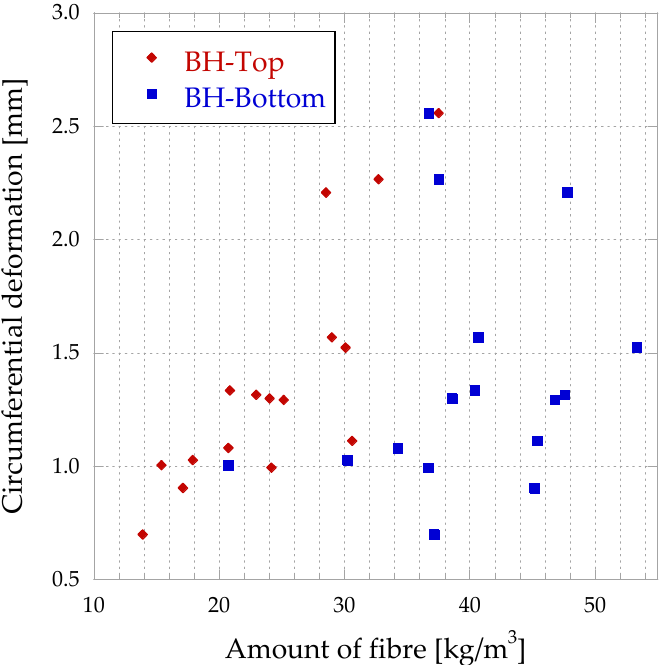
Figure 18. Correlation between circumferential deformation vs. fibre quantity for BH as a function of the height position.